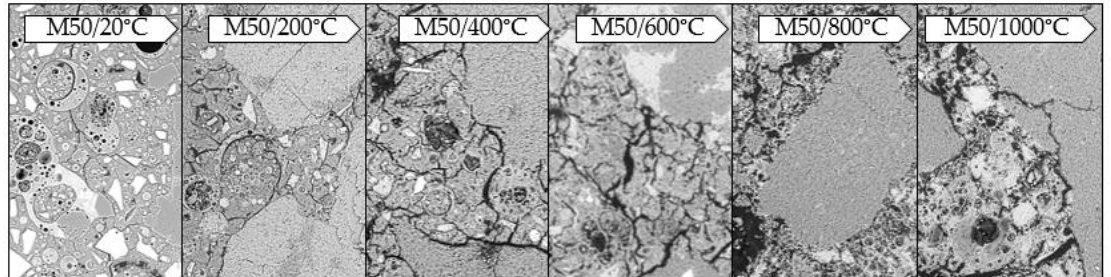
Figure 10. Photographs taken under a scanning microscope using a BSD detector, under variable vacuum conditions, 500× magnification, EHT 20 kV, WD 7.5–9.5 mm, mortar with GGBFS.